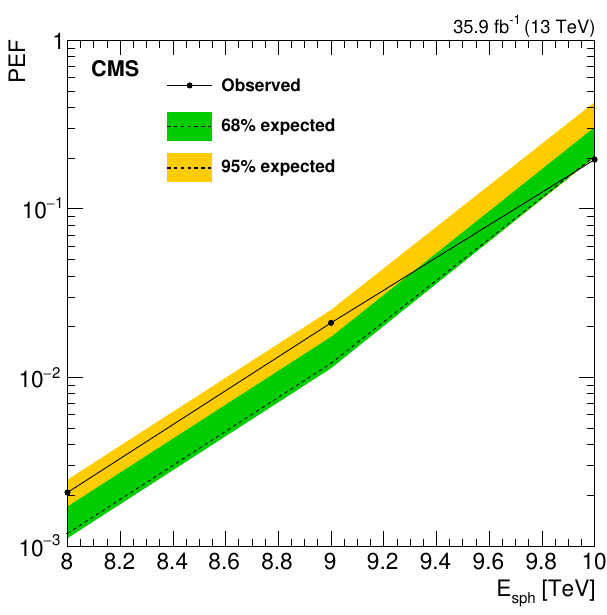
Figure 12 . Observed (solid curve) and expected (dashed black curve) 95% CL upper limit on the pre-exponential factor PEF of the sphaleron production as a function of E sph . The inner (outer) band represents the (cid:6) 1 ( (cid:6) 2) standard deviation uncertainty in the expected limit. The area above the solid curve is excluded by this